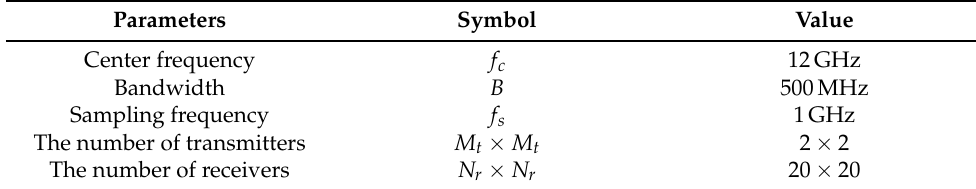
Table 1. MIMO radar simulation parameters.